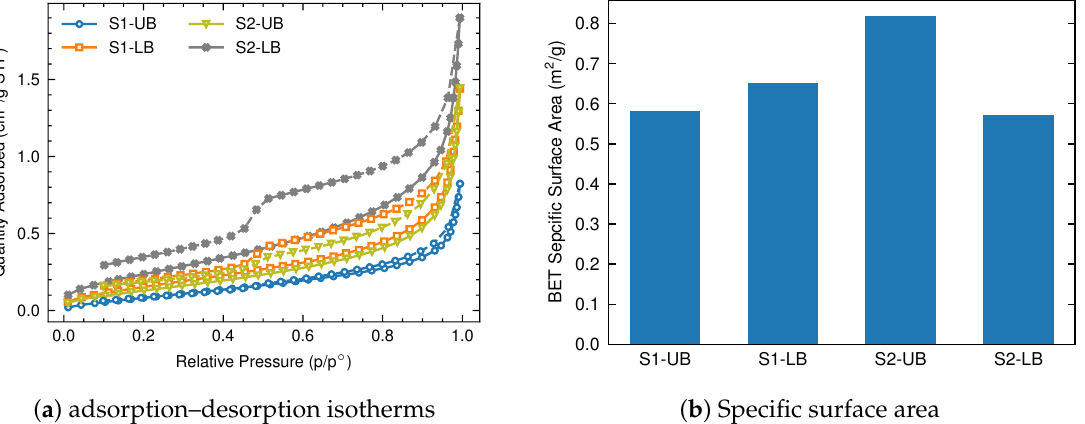
Figure 5. ( a ) The N 2 Adsorption–desorption data (note that the dashed line is the desorption branch); ( b ) the computed specific surface